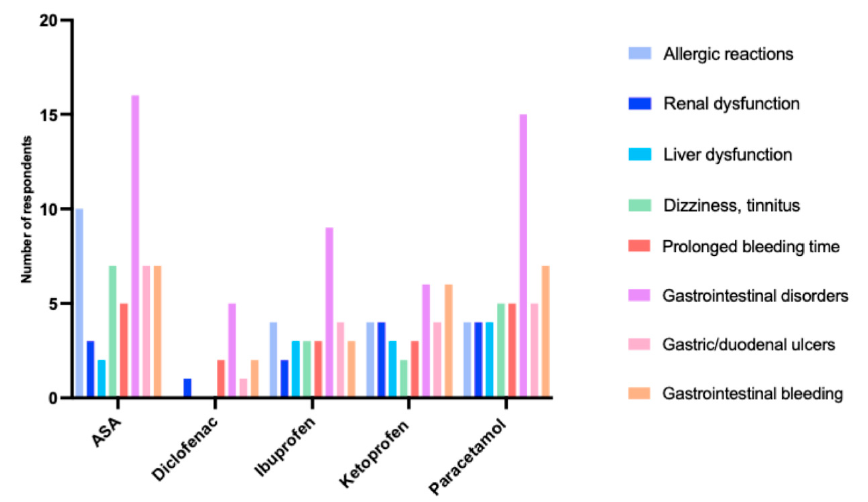
Figure 3. ADRs of the most commonly used NOAs in geriatric patients.